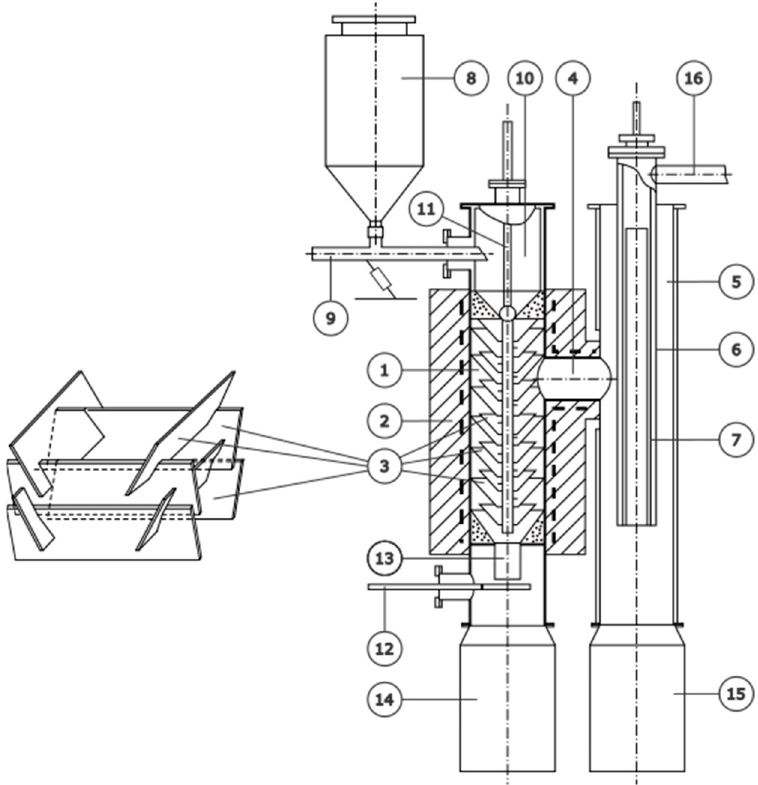
Figure 2. Scheme of vacuum sublimation unit with rheological movement of disperse materials: (1) sublimator, (2) electric furnace, (3) inclined surfaces, (4) steam pipeline, (5) condenser, (6) pipe, (7) fabric filter, (8) hopper for raw materials, (9) vibrating loader, (10) intermediate vessel, (11) rod with a cone gate, (12) vibrating unloader, (13) mouth, (14) receiving hopper for residue, (15) receiving hopper for condensate, (16) vacuum conduit.